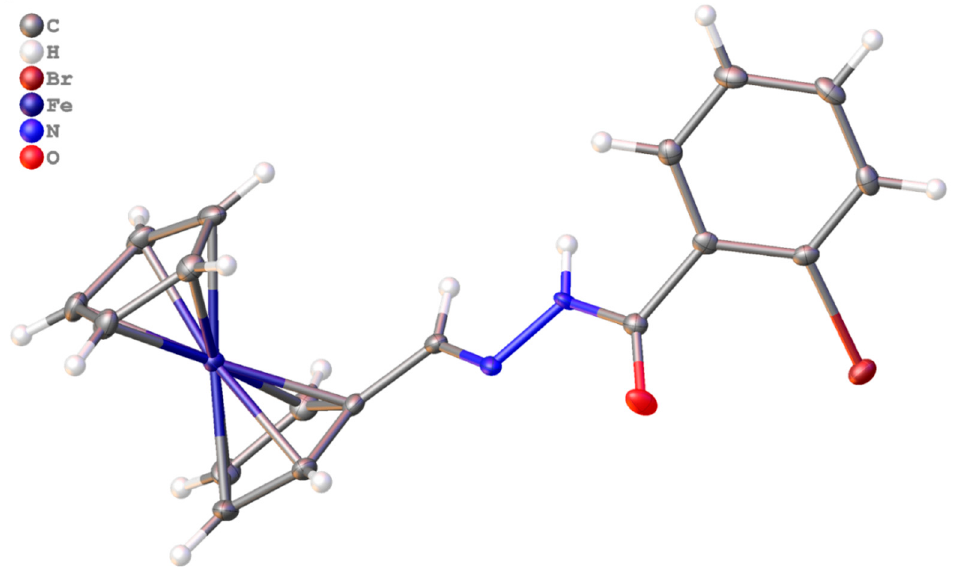
Scheme 1. Synthetic route for the ferrocene- N -acyl hydrazone derivatives.